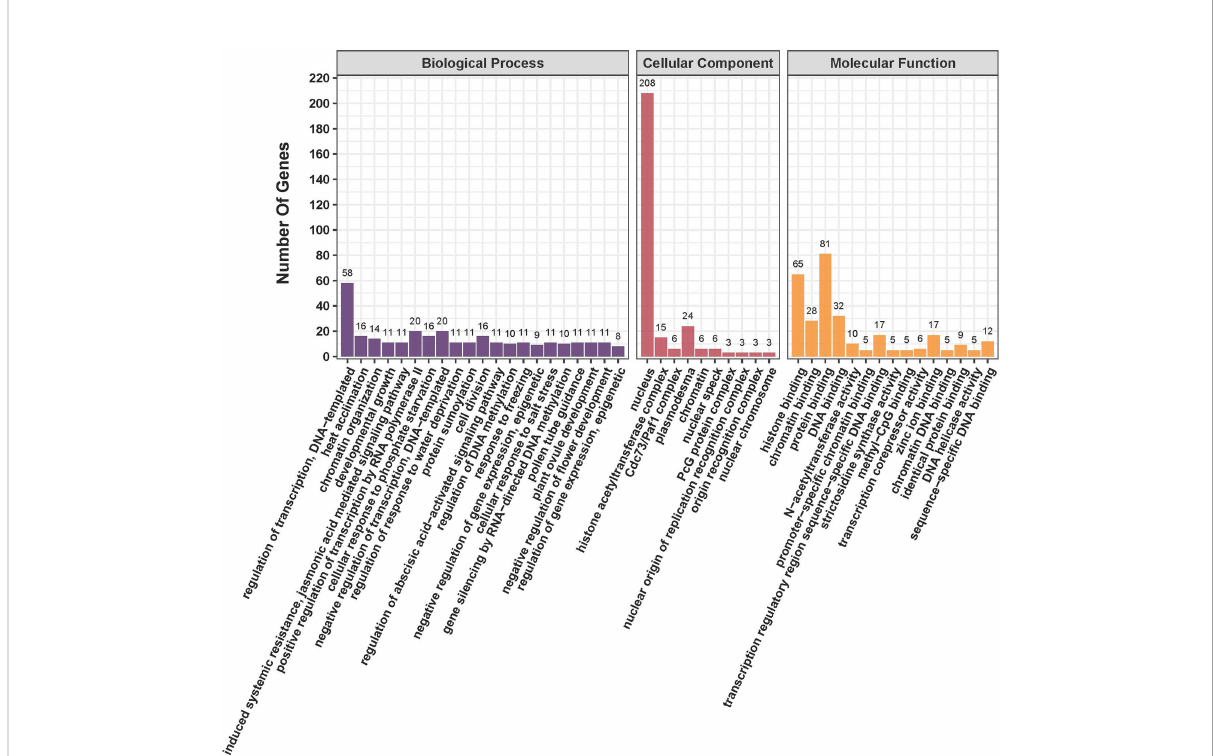
FIGURE 6 Functional annotation analysis of TaPHD genes. Gene Ontology (GO) classi fi cation based on TaPHD gene annotation. The GO terms are grouped into three main categories: purple for Biological Processes, red for Cellular Components, and yellow for Molecular